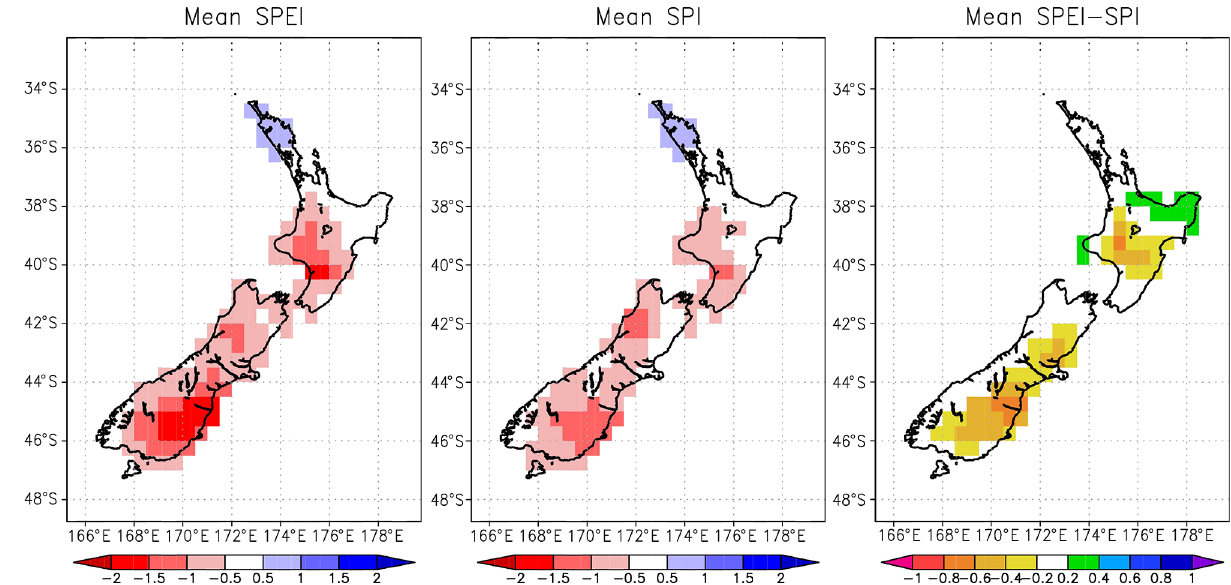
Figure 3. Mean SPEI, SPI and SPEI-SPI difference over drought events where the SPEI area in drought is more than 10% greater than for the SPI.